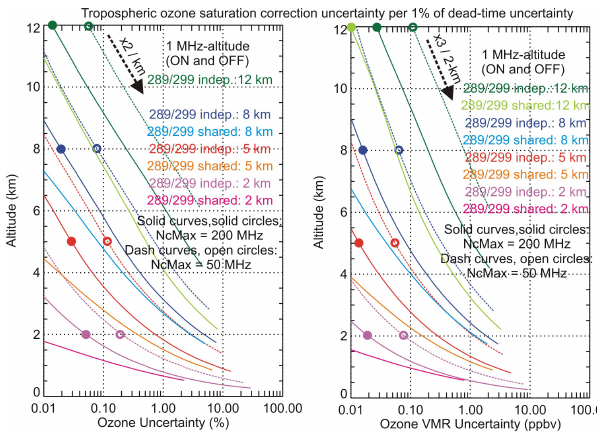
Figure 4. Same as Fig. 3, but for tropospheric ozone systems. See text for